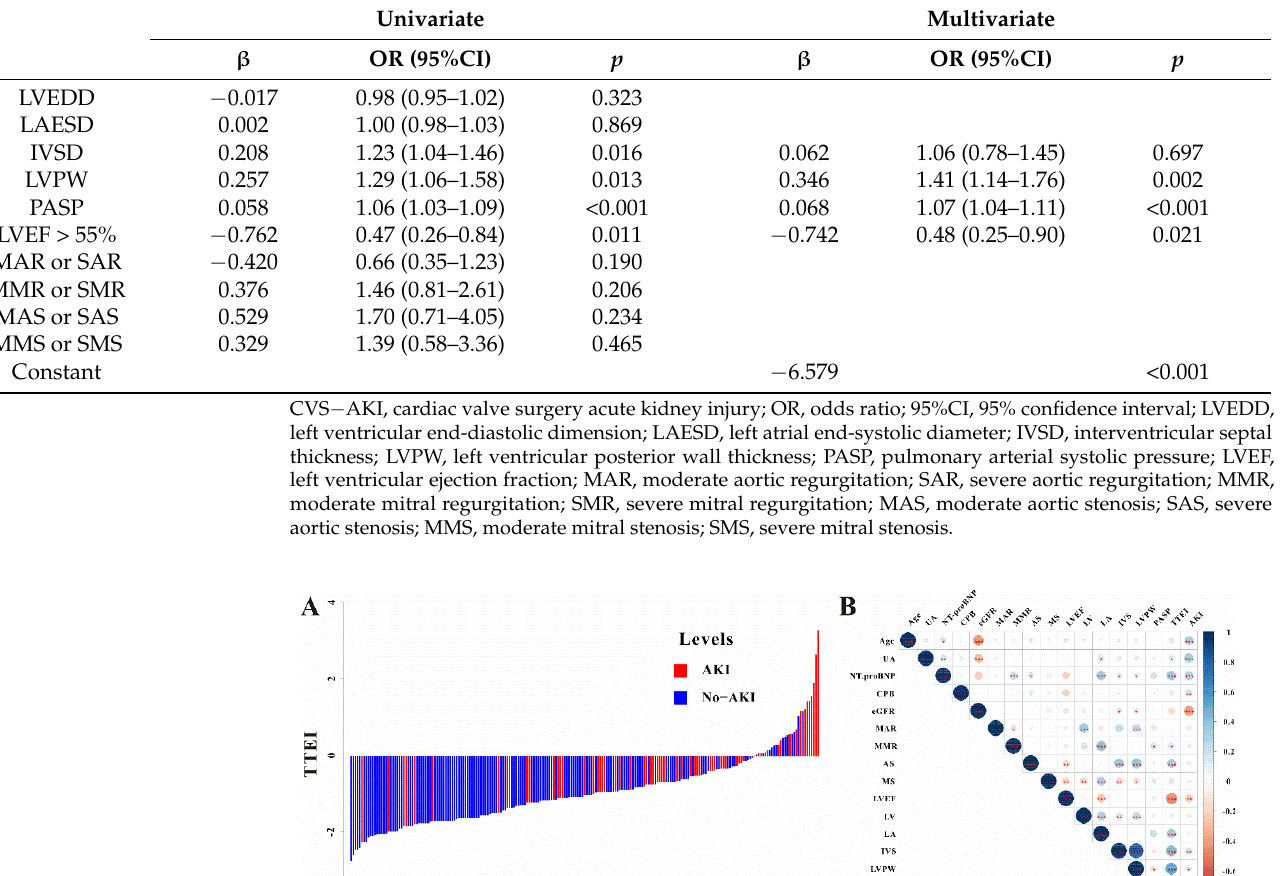
TTEI was calculated based on the ten parameters obtained from TTE by multivariable logistic regression. As shown in Table 2, LVPW, LVEF > 55%, and PASP were found to be independent risk factors for CVS − AKI. Therefore, based on the β coefficients, the TTEI was calculated as follows: − 6.579 + 0.068 × PASP (mmHg) − 0.742 × LVEF (>55%, yes or no) + 0.346 × LVPW (mm). The TTEI for each patient presented as a waterfall plot demonstrated significant differences between AKI and no-AKI ( p < 0.001, Figure 3A). As described in Figure 3B, the level of TTEI was significantly correlated with some parameters of TTE as well as clinical factors. Table 2. Logistic regression models of transthoracic echocardiography parameters for CVS − AKI. Univariate Multivariate